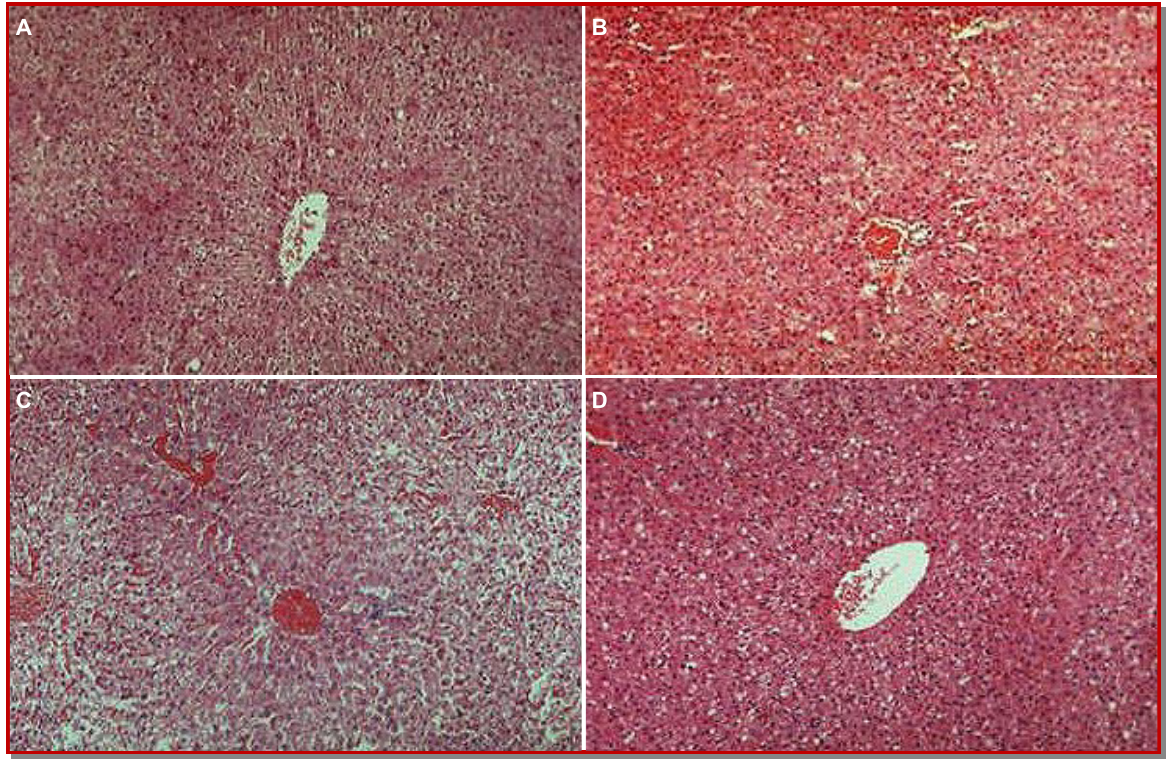
Figure 1: Histopathological section of liver of an adult guinea pig (H & E x 85) showing A) central vein congestion and sinusoidal congestion; B) treated with turmeric 4 mg/day (H & E x 85) showing central vein congestion and slightly swollen hepatocytes; C) treated with garlic 4 mg/day (H & E x 85) showing central vein congestion and slightly swollen hepatocytes; D) treated with both turmeric and garlic 4 mg/day (H & E x 85) showing central vein congestion and sinusoidal